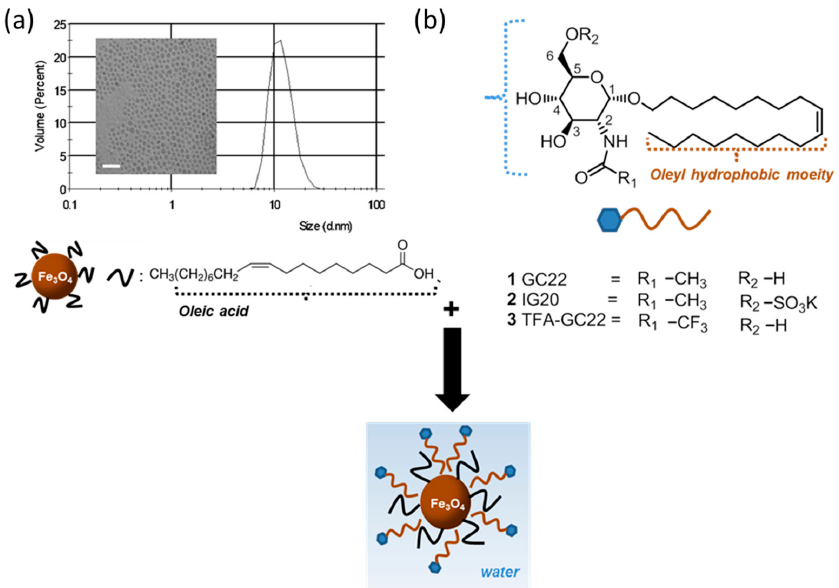
Figure 1. Scheme of the synthesis of the glycosides-coated IONP micelles. ( a ) Hydrodynamic size and TEM image (scale bar: 25 nm) of OA-IONP; ( b ) Structure of the bioactive glycosides.